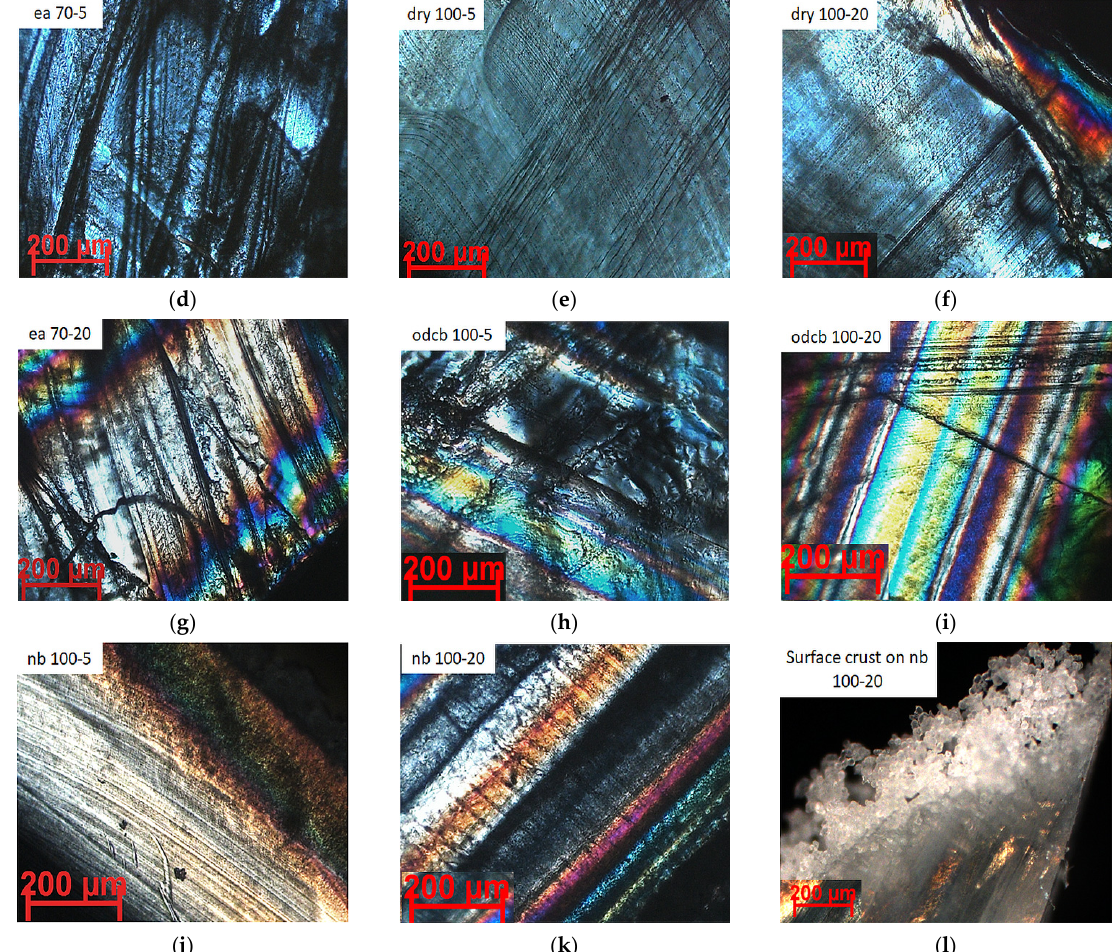
Figure 6. Polarised optical micrograph (POM) of raw PLLA ( a ); PLLA annealed at 70 °C for 5 min ( b ); PLLA annealed at 70 °C for 20 min ( c ); PLLA crystallized in ethyl acetate at 70 °C for 5 min ( d ); PLLA annealed at 100 °C for 5 min ( e ); PLLA annealed at 100 °C for 20 min ( f ); PLLA crystallized in ethyl acetate at 70 °C for 20 min ( g ); PLLA crystallized in ODCB at 100 °C for 5 min ( h ); PLLA crystallized in ODCB at 100 °C for 20 min ( i ); PLLA crystallized in nitrobenzene at 100 °C for 5 min ( j ); PLLA crystallized in nitrobenzene at 100 °C for 20 min ( k , l ).